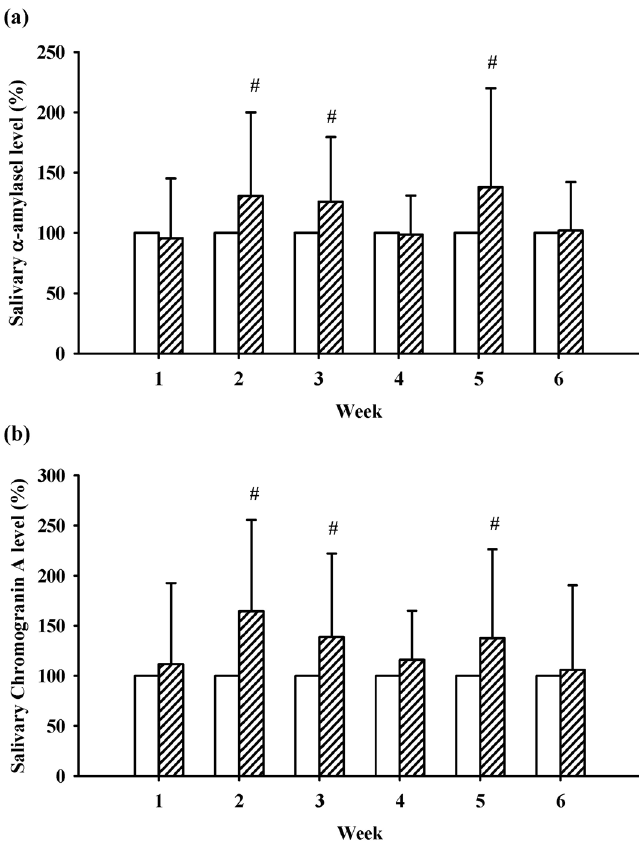
Figure 2. The preactivity and postactivity relative levels of α-amylase ( a ) and chromogranin A ( b ) in saliva at different weeks. The empty bar represents preactivity. The slashed bar represents postactivity. # p < 0.01 compared to preactivity at each week. Data are presented as the mean ±